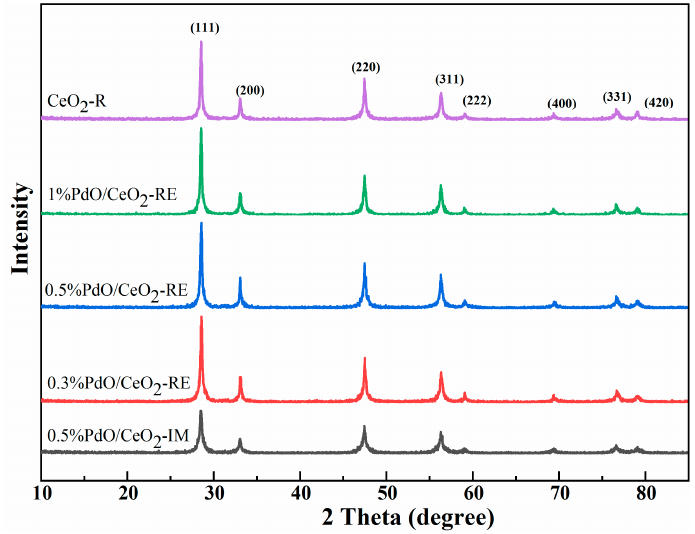
Figure 1. XRD pattern of CeO 2 -R and Pd/CeO 2 catalysts. Table 1. Pd content, dispersion and texture parameters of CeO 2 -R and Pd/CeO 2 catalysts. Samples